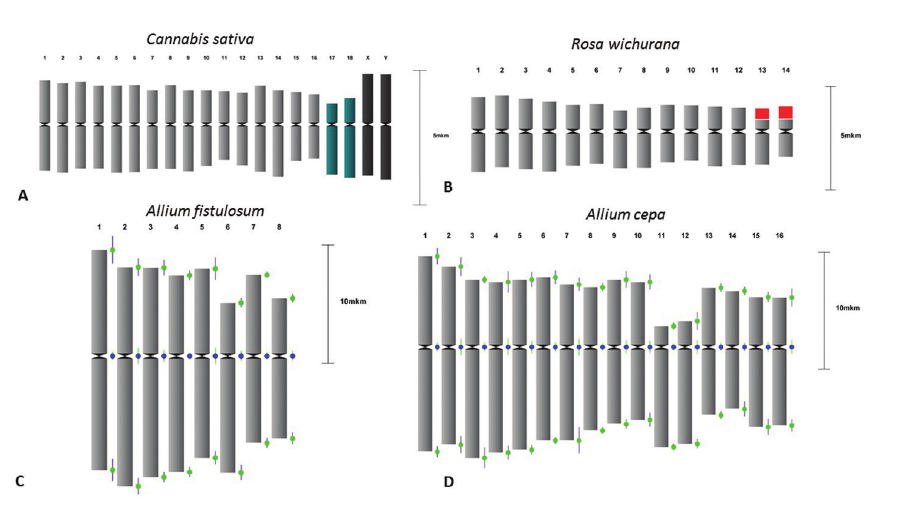
Figure 2. Examples of basic karyotype measurements and idiogram constuction by DRAWID. A Chro- mosomes of C. sativa (2 n = 20); sex (black color) and NOR-bearing (green color) chromosomes are high- lighted B Idiogram of Rosa wichurana ; satellites on chromosomes 13 and 14 are colored in red C Idiogram of Allium fistulosum after measurement of the chromosomes, and application of the function “reduce karyo” merging homologuous chromosomes to obtain a monoploid idiogram, standard deviation bars are shown D Idiogram of Allium cepa constructed after measurements of 3 metaphases and application of the “get average karyo” function to obtain the average idiogram, standard deviation bars are